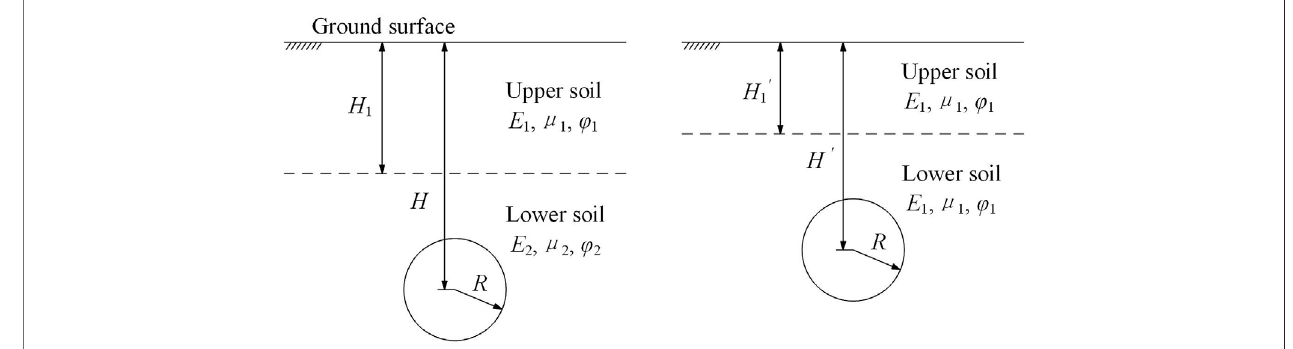
FIGURE 1 | Stratigraphic transformation model.